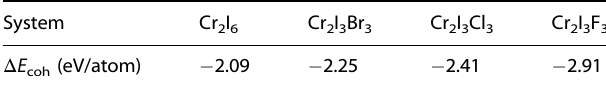
Table 3. Summarization of energy differences for FM and